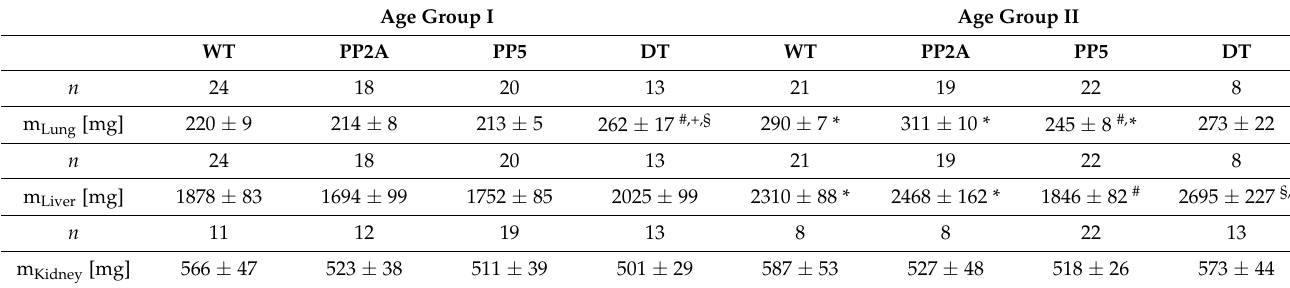
Figure 2. Cardiac gravimetry and survival. ( A ): Relative heart weight (heart weight/body weight quotient) of young (age group I) and middle-age (age group II) mice, ( B ): Time dependent survival of WT, PP2A, PP5 and DT mice. WT: n = 10; PP2A: n = 13; PP5: n = 13; DT: n = 25. ( C ): Photography of typical hearts of mice of both age groups from the four genotypes studied, ( D ): body weight of young and middle-age mice, # p < 0.05 vs. WT; + p < 0.05 vs. PP2A; § p < 0.05 vs. PP5; * p < 0.05 vs. age group I. Table 1. Organ weights (m = weight) of young (age group I) and middle-age (age group II) mice. Age Group I Age Group